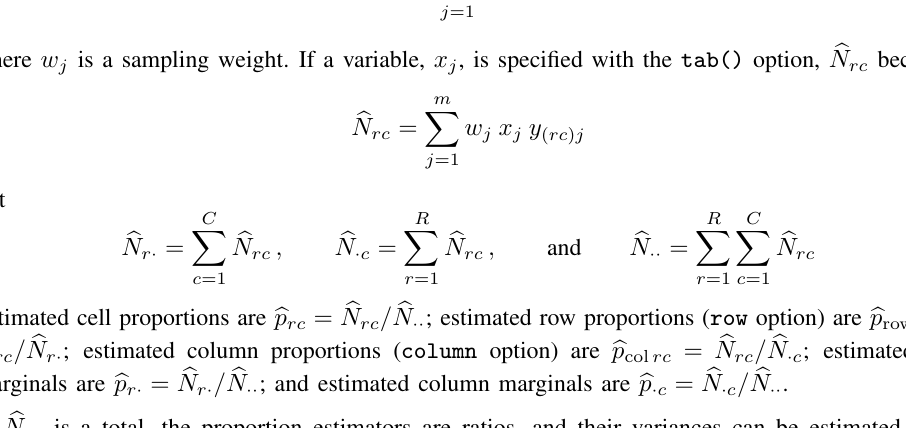
svy: tabulate twoway — Two-way tables for survey data